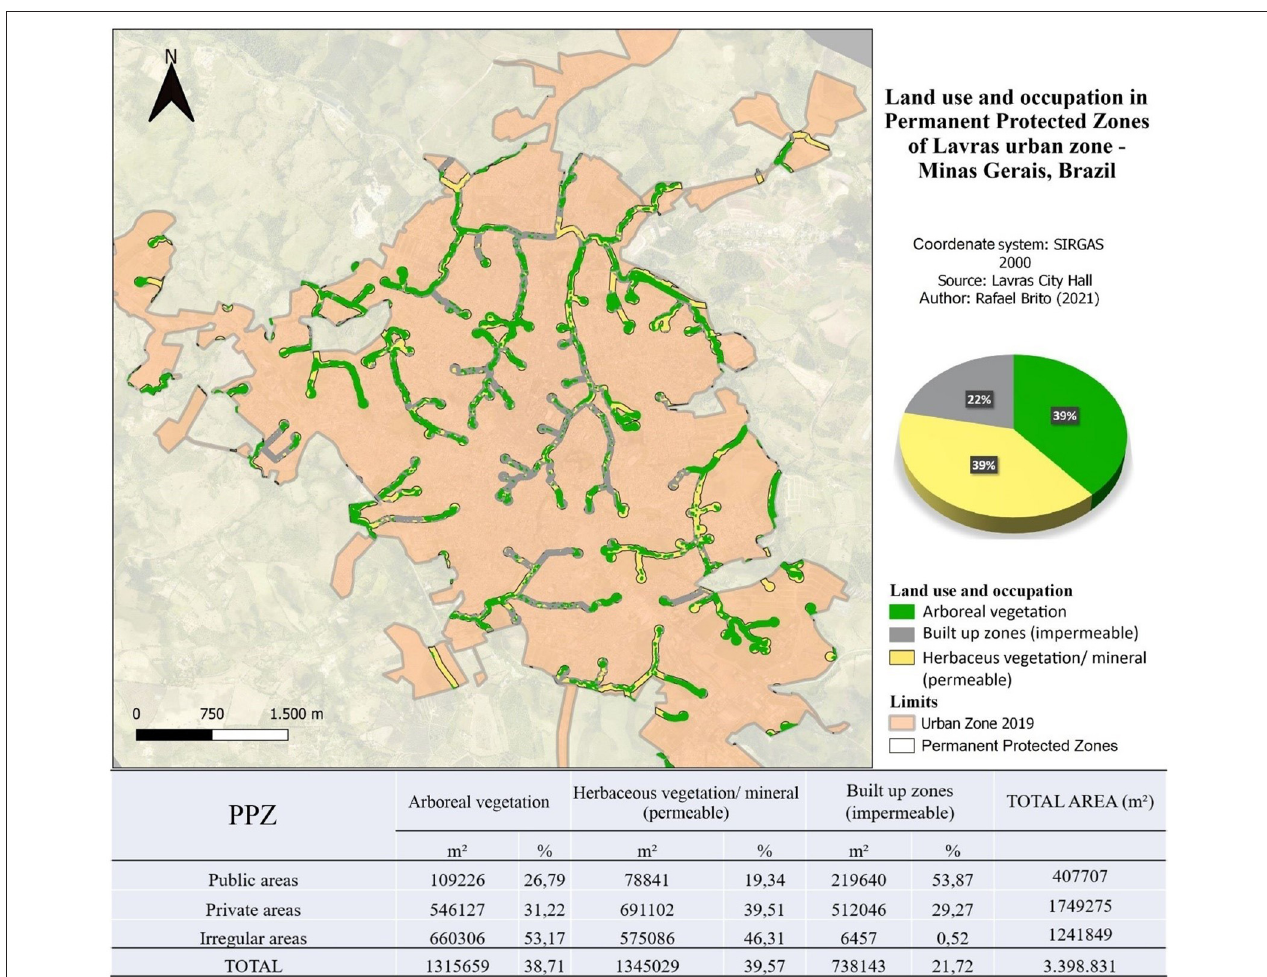
FIGURE 9 | Analysis of land use and occupation in PPZs of springs and watercourses in the urban area of Lavras-MG, in 2019. Source: Sousa R. B. et al.